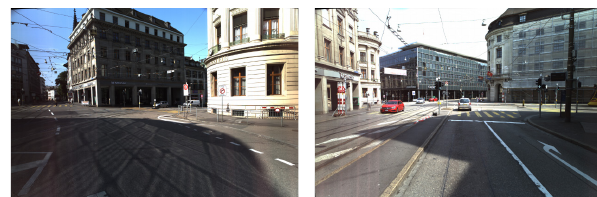
Figure 3. Mobile mapping imagery of image sequence 1 (left) and image sequence 3 (right) showing the test area